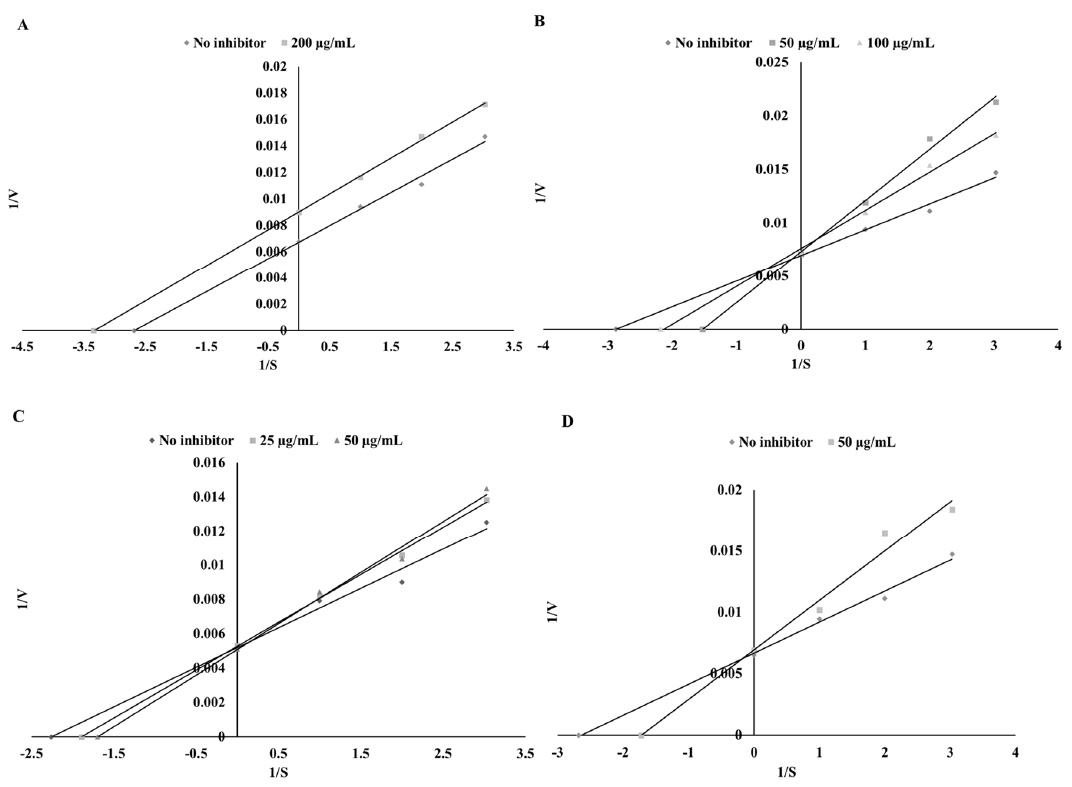
Figure 1. Mode of TPO inhibition by pure polyphenols: apigenin ( A ), catechin ( B ), kaempferol ( C ), and sinapinic acid ( D ).